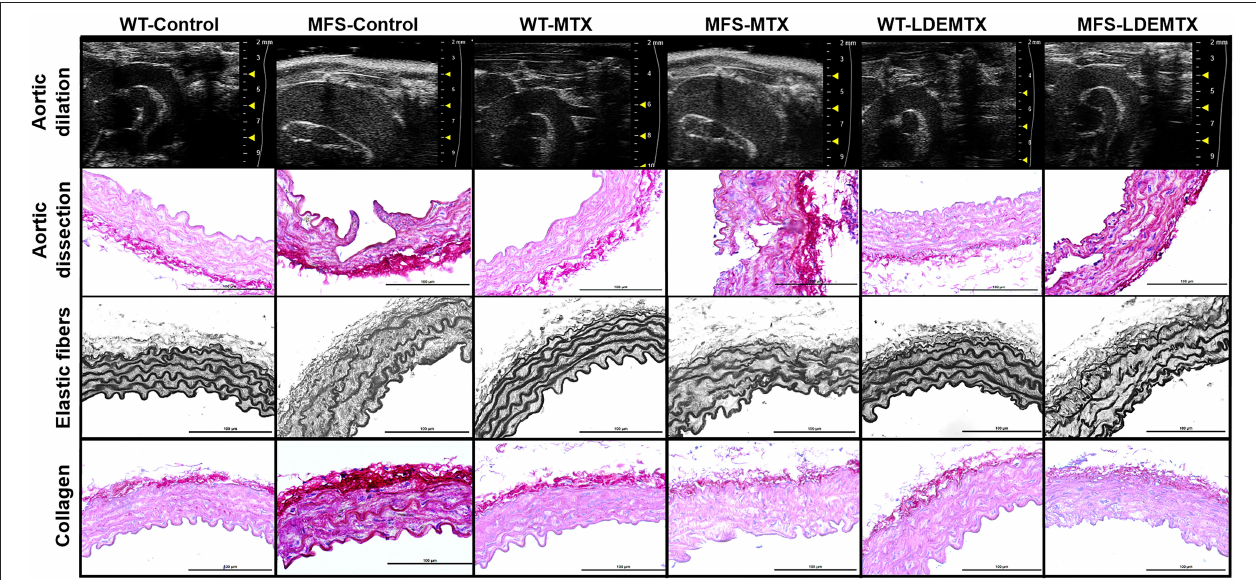
FIGURE 1 | Representative echocardiographic and morphometric images in wild-type (WT) and Marfan syndrome (MFS) mice at 6 months of age, treated with methotrexate (MTX) and lipid nanoparticles methotrexate (LDEMTX), showing the dilatation and dissection, disorganization, and disruption of elastic fibers and fibrosis (in dark red) in the